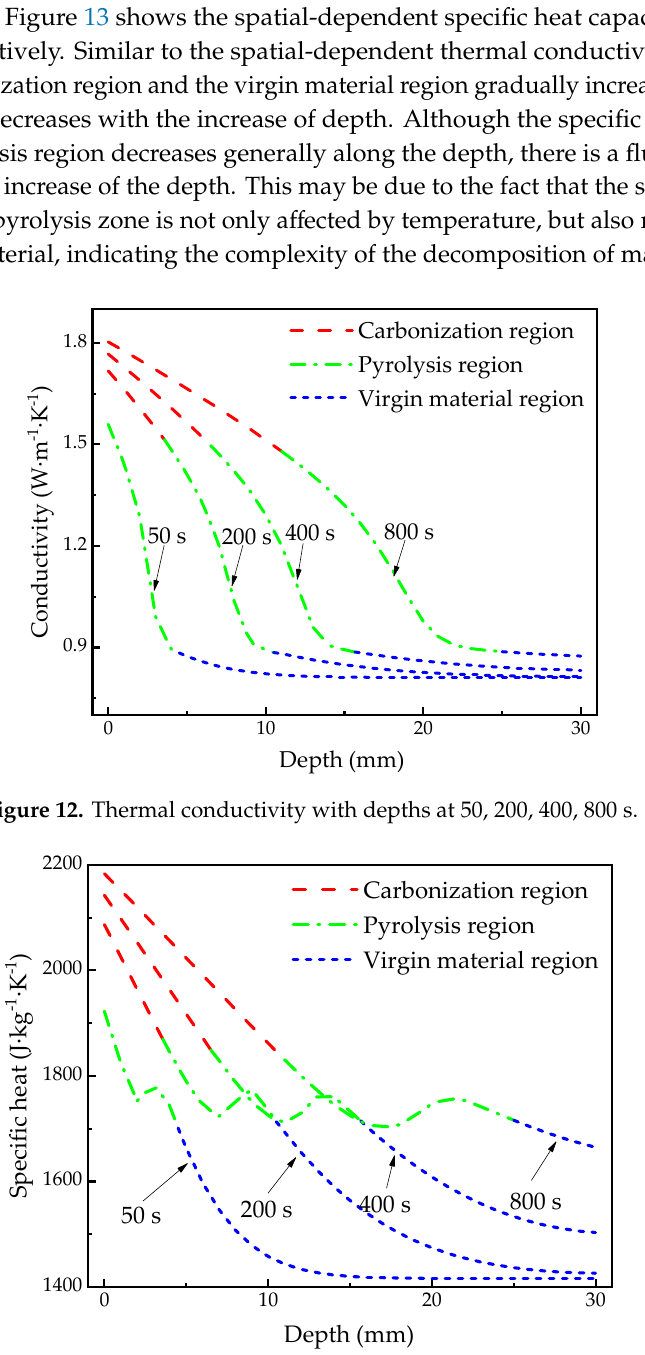
Figure 13. Specific heat capacity with depths at 50, 200, 400, 800 s.